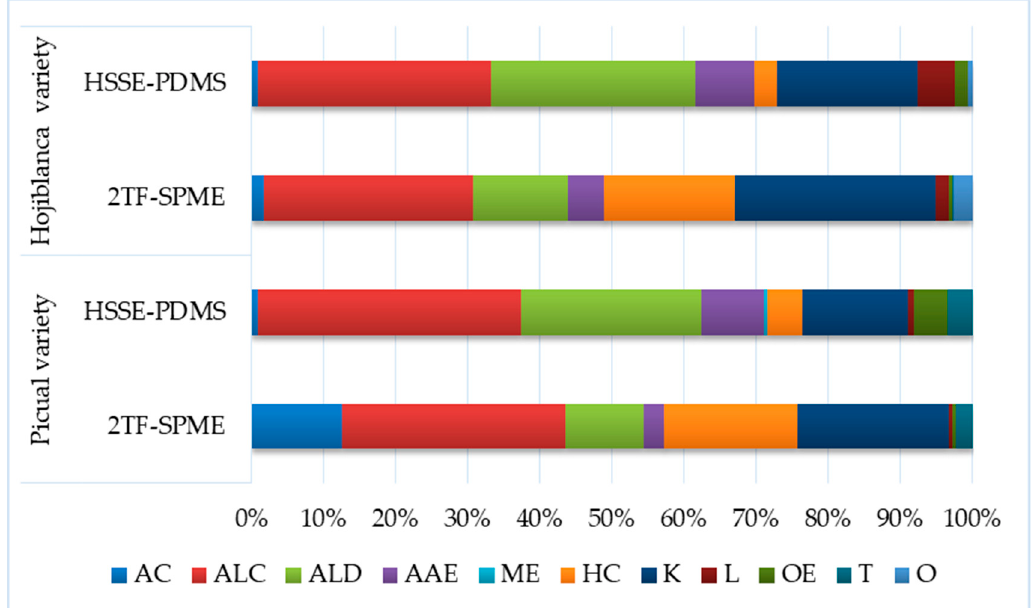
Figure 2. Percentage of total peak area values of major chemical groups of EVOO Picual and Hojiblanca varieties obtained by HSSE-PDMS and 2TF-SPME.